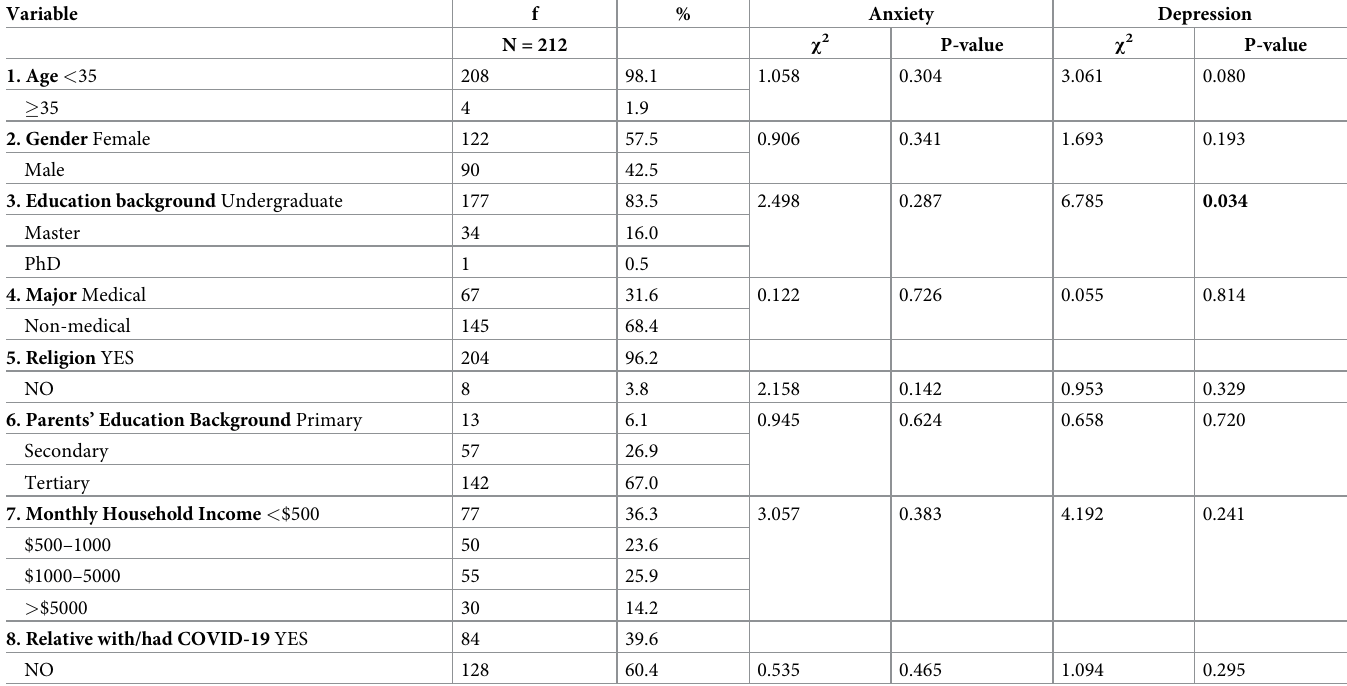
Table 7. Descriptive analysis of association between sociodemographic characteristics and psychological state on the Africans In Africa group.